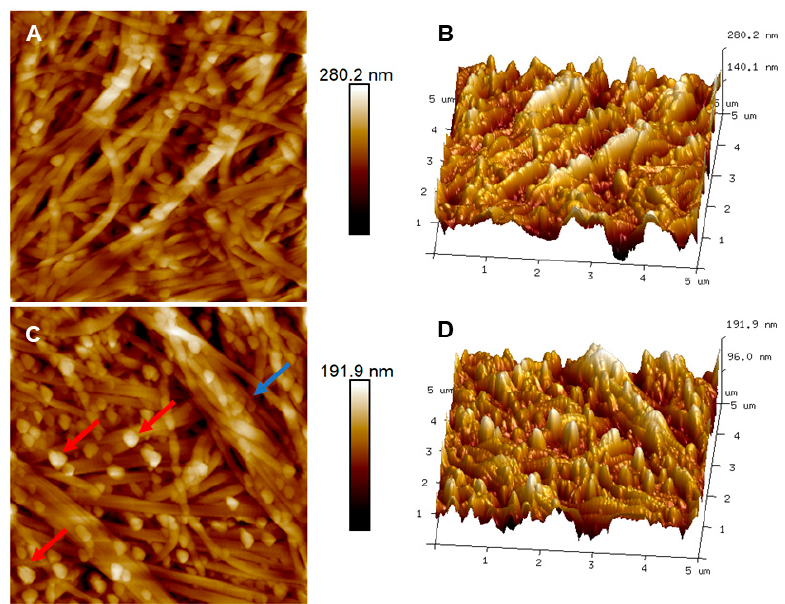
Figure 4. Two-dimensional and three-dimensional topographic maps of AFM from different regions of Bowman’s layer in human corneas. ( A ) Image of the 2D peripheral region and ( B ) its respective 3D view. ( C ) A 2D image of the central region and ( D ) its respective 3D image. Scan area = 5 × 5 µm.